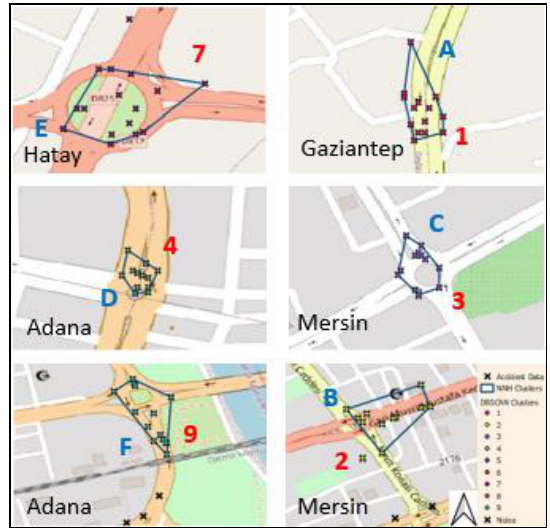
Figure 4. Mersin Region Speed-related Accident Clusters Map of 2014-2015 (NNH and DBSCAN are overlaid)